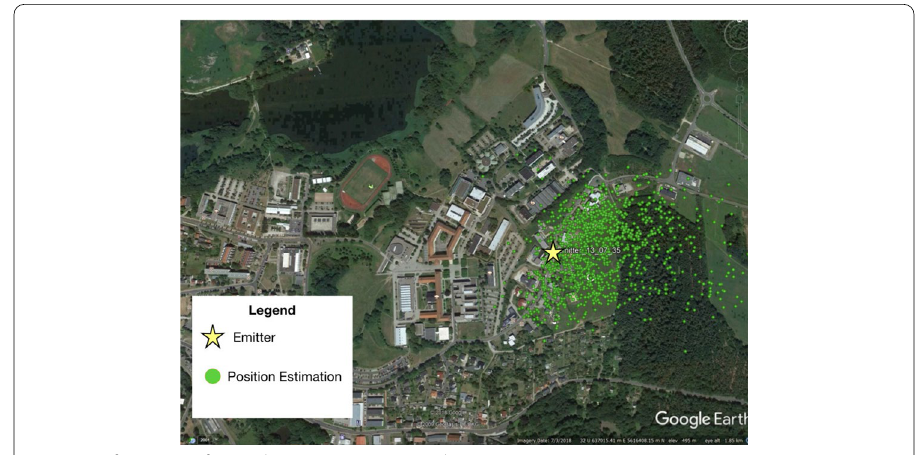
Fig. 2 Performance of a Localization System in Outdoor Scenario